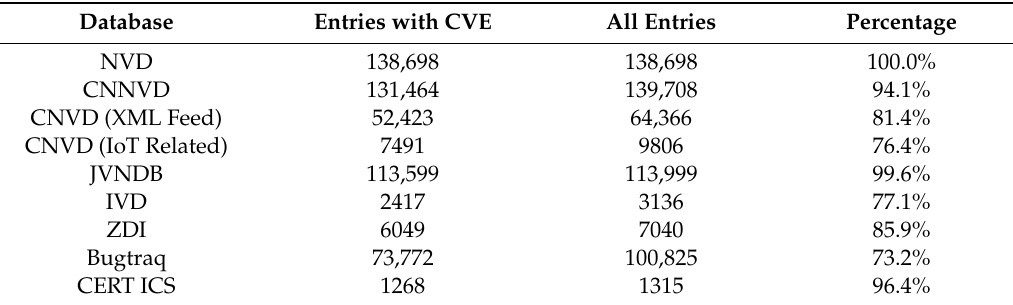
Table 12. CVE inclusion rate—Ratio of the number of entries that include CVE IDs to the total number of entries available in the